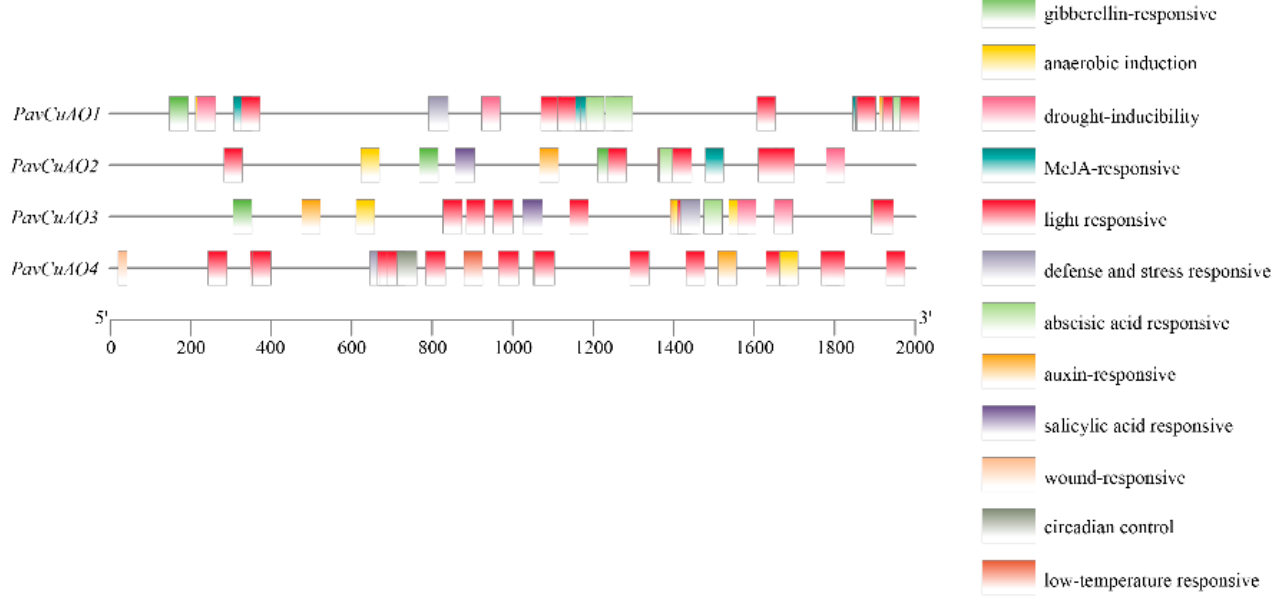
Figure 2. Analysis of cis -elements in PavCuAOs promoters.